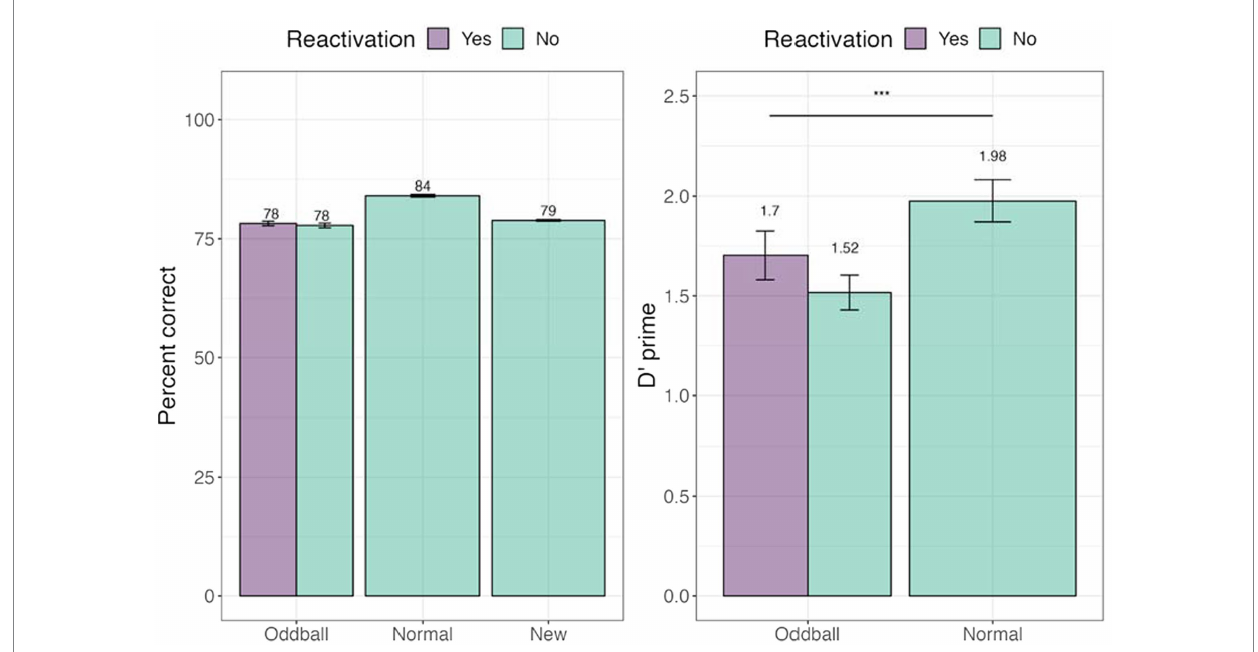
FIGURE 8 Percent and correct and d’-prime for the visual recognition task in Experiment 2. ***The significance of p < 0.001. Error bars represent standard errors of the mean.